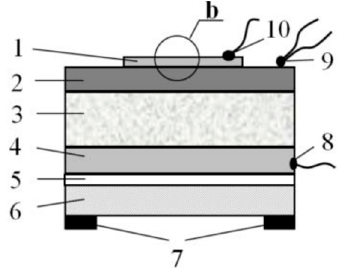
Figure 2. Capacitor sensor: 1—SnO 2 /Pd gate; 2—SiO 2 film; 3—Si substrate; 4—Al electrode;